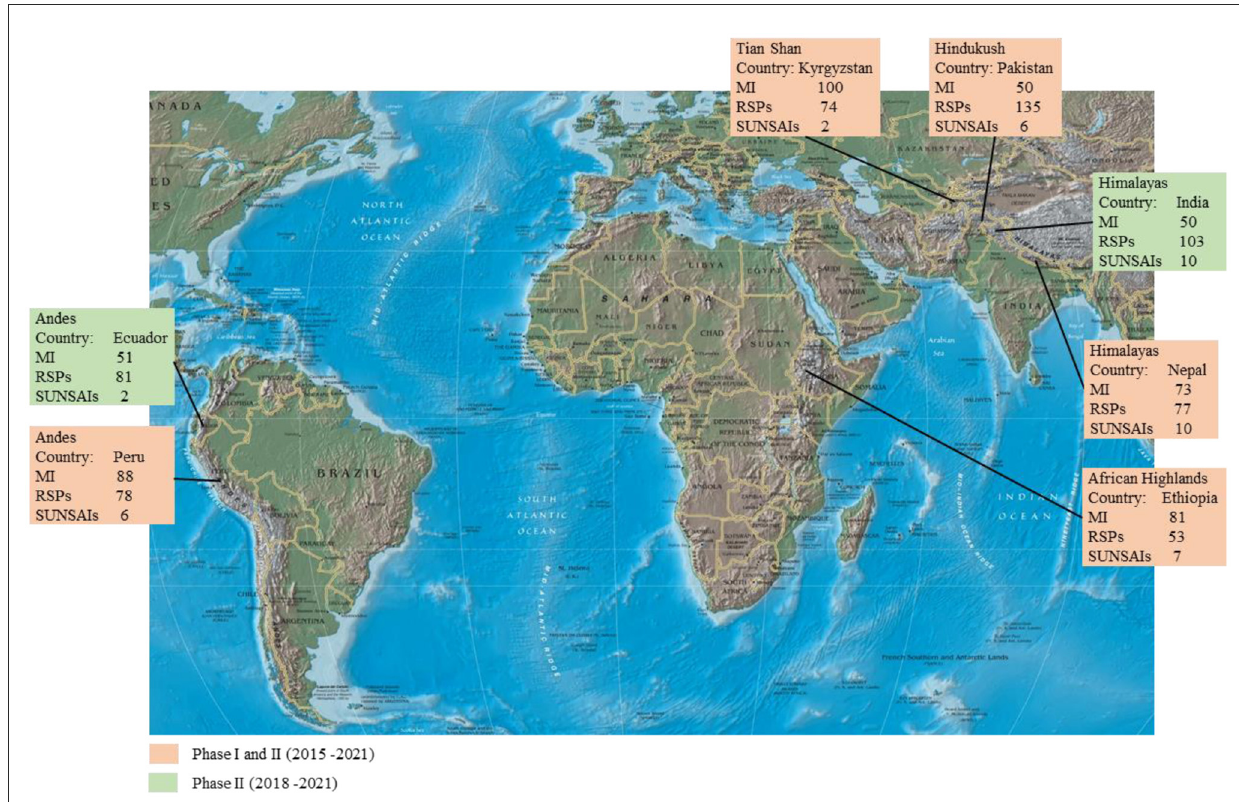
FIGURE2 Geographical coverage of the NMA project and number of micro-interventions (MIs) supported by the project, trained rural service providers (RSPs) and scaled-up nutrition-sensitive interventions (SUNSAIs) per country.